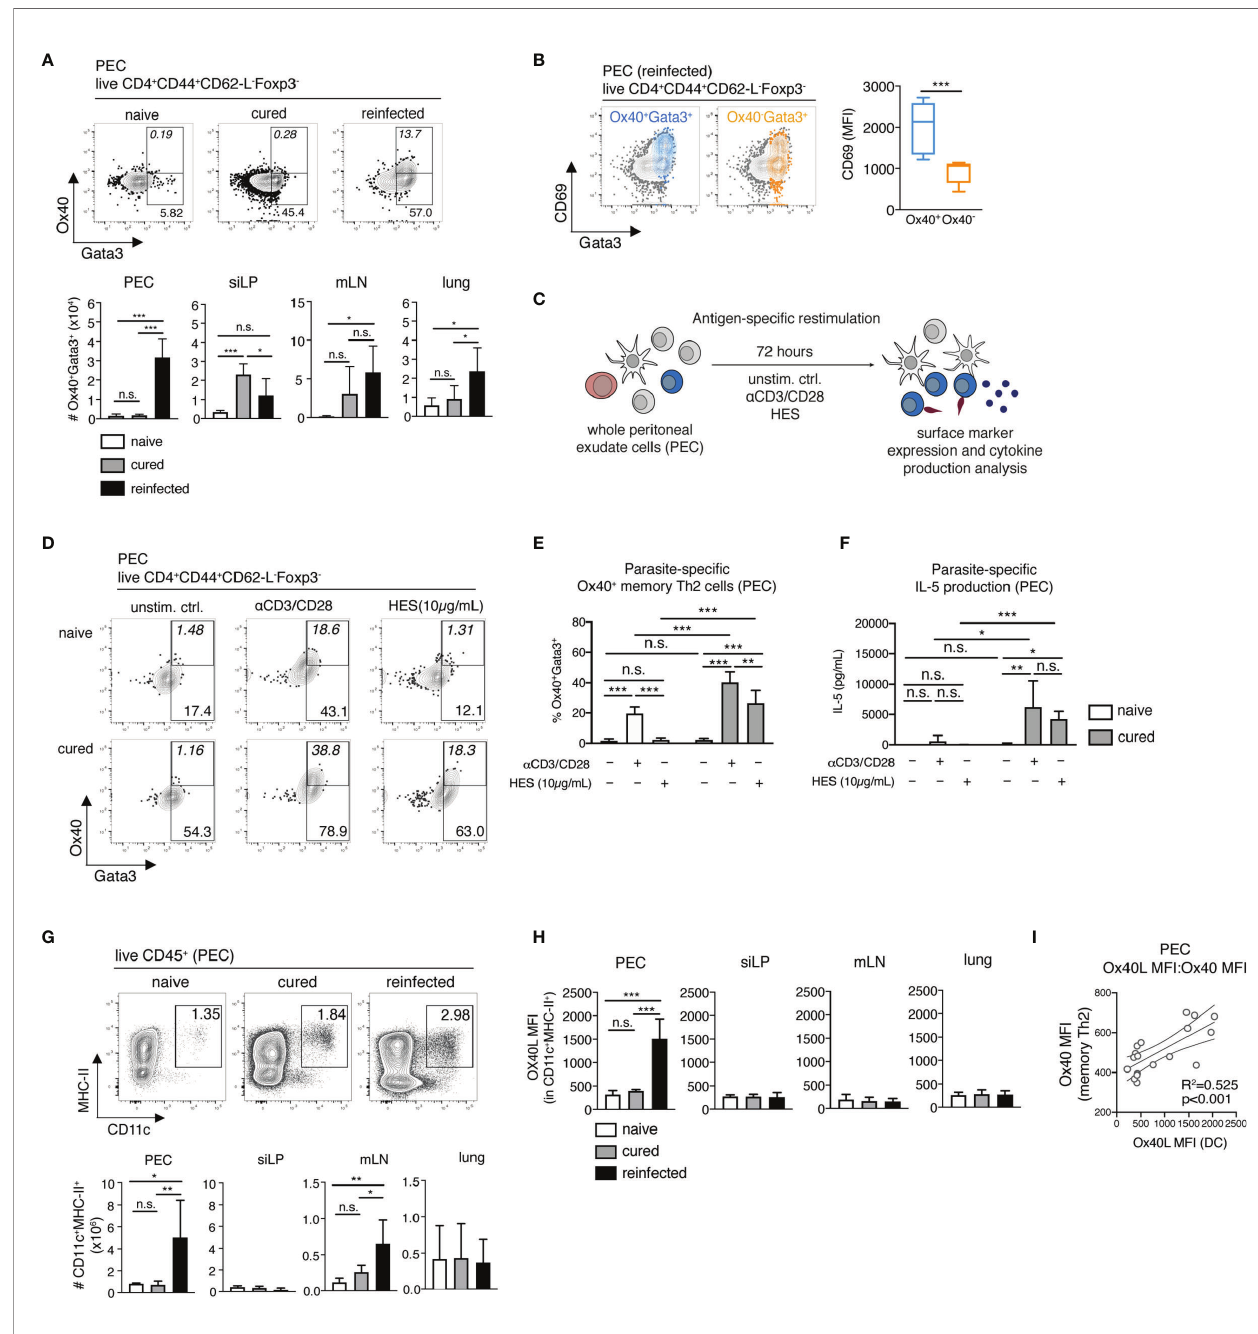
FIGURE 3 | Parasite-speci fi c Ox40 + memory Th2 cells and Ox40L + DCs accumulate in the peritoneum during early recall responses to H. polygyrus . (A) Exemplary contour plots of Ox40 and Gata3 expression and absolute cell numbers of Ox40 + Gata3 + memory Th2 cells in the PEC, siLP, mLN and lung of naïve, cured and reinfected mice. (B) Exemplary overlay plots and mean fl uorescence intensity of CD69 expression by Ox40 + Gata3 + (blue) and Ox40 - Gata3 + (yellow) memory Th2 cells in the PEC of reinfected mice. (C) Schematic representation of the antigen-speci fi c in vitro restimulation of whole PEC and mLN cells. (D) Exemplary plots of Ox40 and Gata3 expression by CD4 + CD44 + CD62-L - Foxp3 - memory Th2 cells following a 72-hour in vitro restimulation with a CD3/CD28 monoclonal antibodies and H. polygyrus excretory/secretory antigen (HES) of whole PEC cells from naïve and cured mice. (E) Frequencies of Ox40 + Gata3 + memory Th2 cells following antigen-speci fi c in vitro restimulation. (F) IL-5 cytokine levels in cell culture supernatants following the in vitro restimulation of whole PEC cells. (G) Exemplary FACS plots and absolute cell numbers of peritoneal CD11c + MHC-II + CD45 + dendritic cells (DC) in a naïve, cured and reinfected mouse. (H) Mean fl uorescence intensities (MFI) of Ox40L on DCs in PEC, siLP, mLN and lung of naïve, cured and reinfected mice. (I) Correlation analysis of Ox40L expression on PEC-resident DCs and Ox40 expression on PEC-resident memory Th2 cells. Statistical analysis in (A-C) was done using one-way ANOVA combined with Tukey ’ s multiple comparison test. Statistical analysis in (I) was performed using Pearson ’ s r test. * p < 0.05, ** p < 0.01, *** p < 0.001, n.s., not signi fi